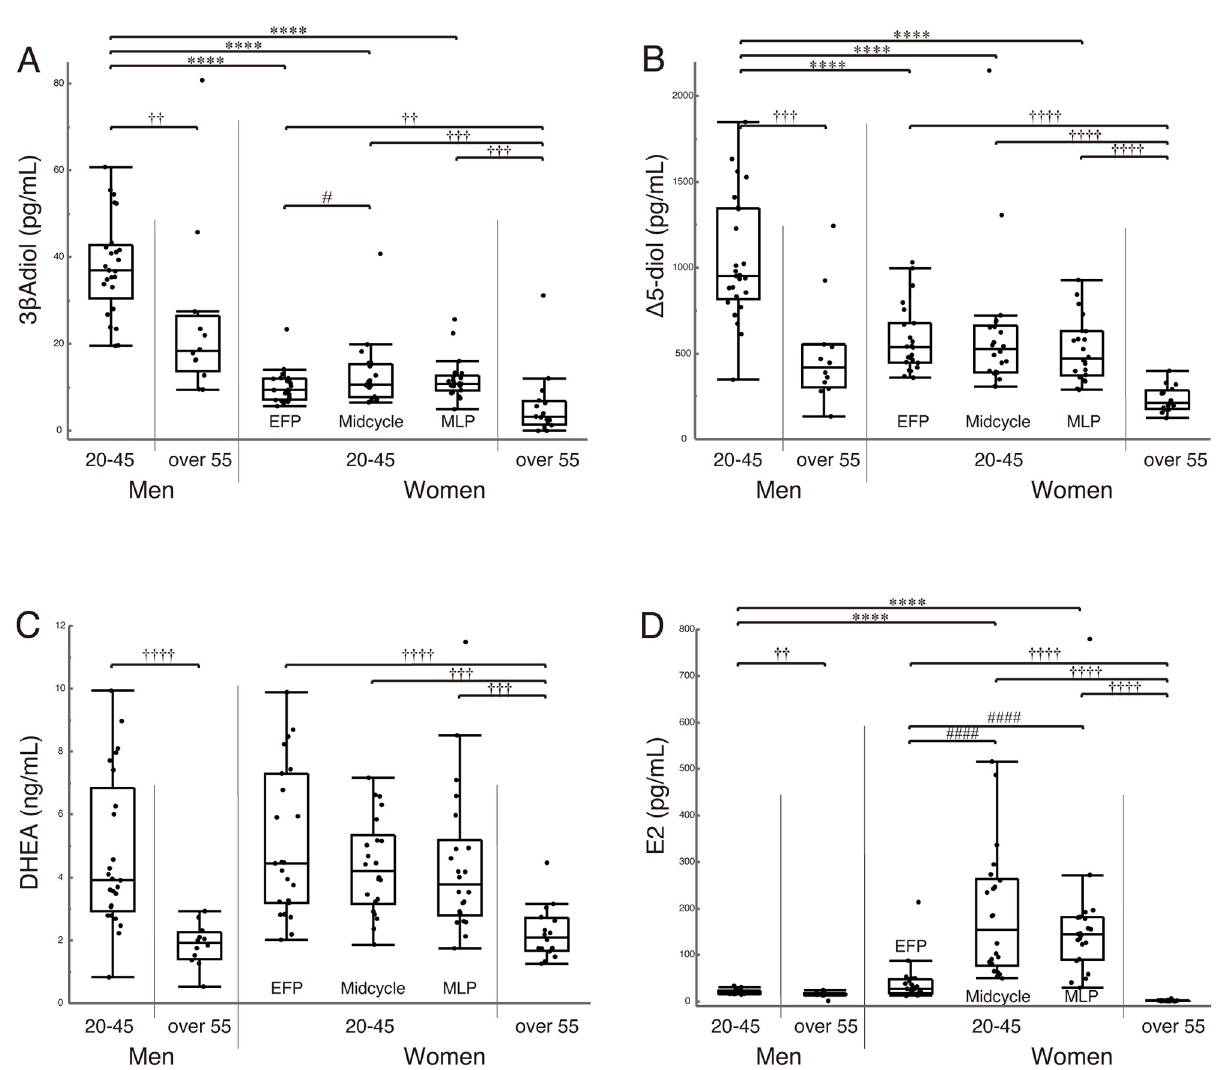
Fig 1. Serum levels of steroids (overall view). Serum levels of 3 β Adiol (A), Δ 5-diol (B), DHEA (C), and E2 (D) in young men aged 20–45, elderly men over 55 years old, young women aged 20–45 at three time-points in their menstrual cycle (EFP, Midcycle, and MLP), and elderly women over 55 years old. Data on elderly men and women are from our previous publication [8]. Median serum levels of each steroid are indicated in each box using horizontal bars. The vertical bars indicate the range, and the horizontal boundaries of each box represent the first and third quartiles. ���� p < 0.0001 as compared between young men and women; # p < 0.05, #### p < 0.0001 as compared during the menstrual cycle (at EFP, Midcycle, and MLP); †† p < 0.01, ††† p < 0.001, †††† p < 0.0001 as compared between young and elderly subjects. Abbreviations : 3 β Adiol , 5 α -androstane-3 β ,17 β -diol; Δ 5-diol , androstenediol; DHEA , dehydroepiandrosterone; E2 , 17 β -estradiol; EFP , early follicular phase; Midcycle , mid-cycle phase; MLP , mid-luteal phase.